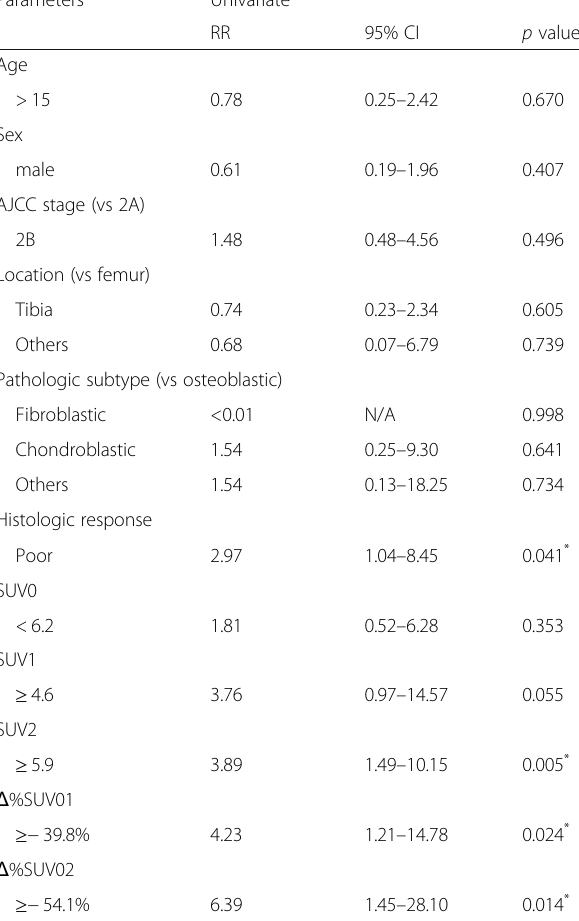
Table 3 Univariate Cox proportional hazards models for event- free survival